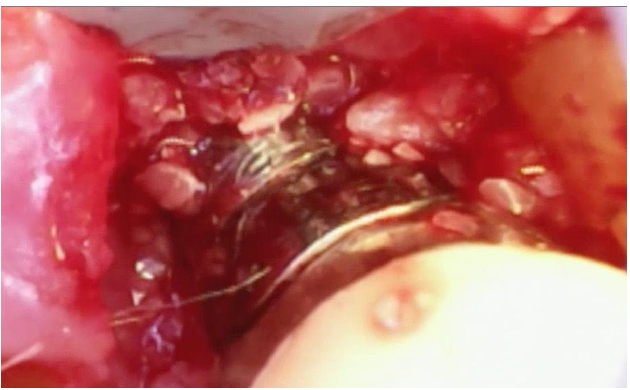
Figure 9. The bony lesion pictured in Figure 8 has been filled with particulate bone-grafting material mixed with EMD.